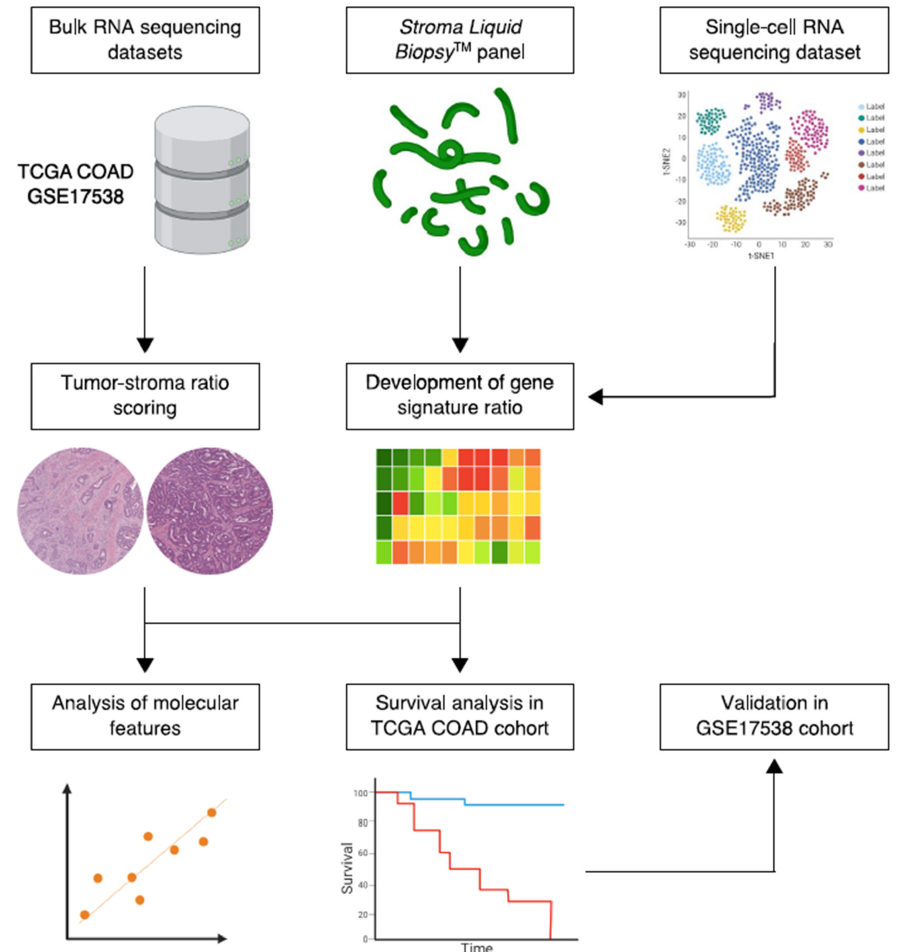
Figure 1. Simplified schematic workflow of the study. Bulk and single-cell RNA sequencing data were collected from public repositories. Constituents of the Stroma Liquid Biopsy panel were used to develop a stromal-epithelial gene signature ratio based on single-cell gene expression of intratumoral cell populations. The histologic tumor-stroma ratio was used to quantify intratumoral stromal content in pathology slides from the TCGA COAD cohort. Subsequently, the gene signature ratio was studied in histologic stroma-high and stroma-low tumors. In addition, the association between the gene signature ratio and established molecular tumor characteristics, such as microsatellite instability and the consensus molecular subtypes, was assessed. Lastly, the prognostic performance of the gene signature ratio was tested in the TCGA COAD discovery cohort and validated in the GSE17358 cohort.